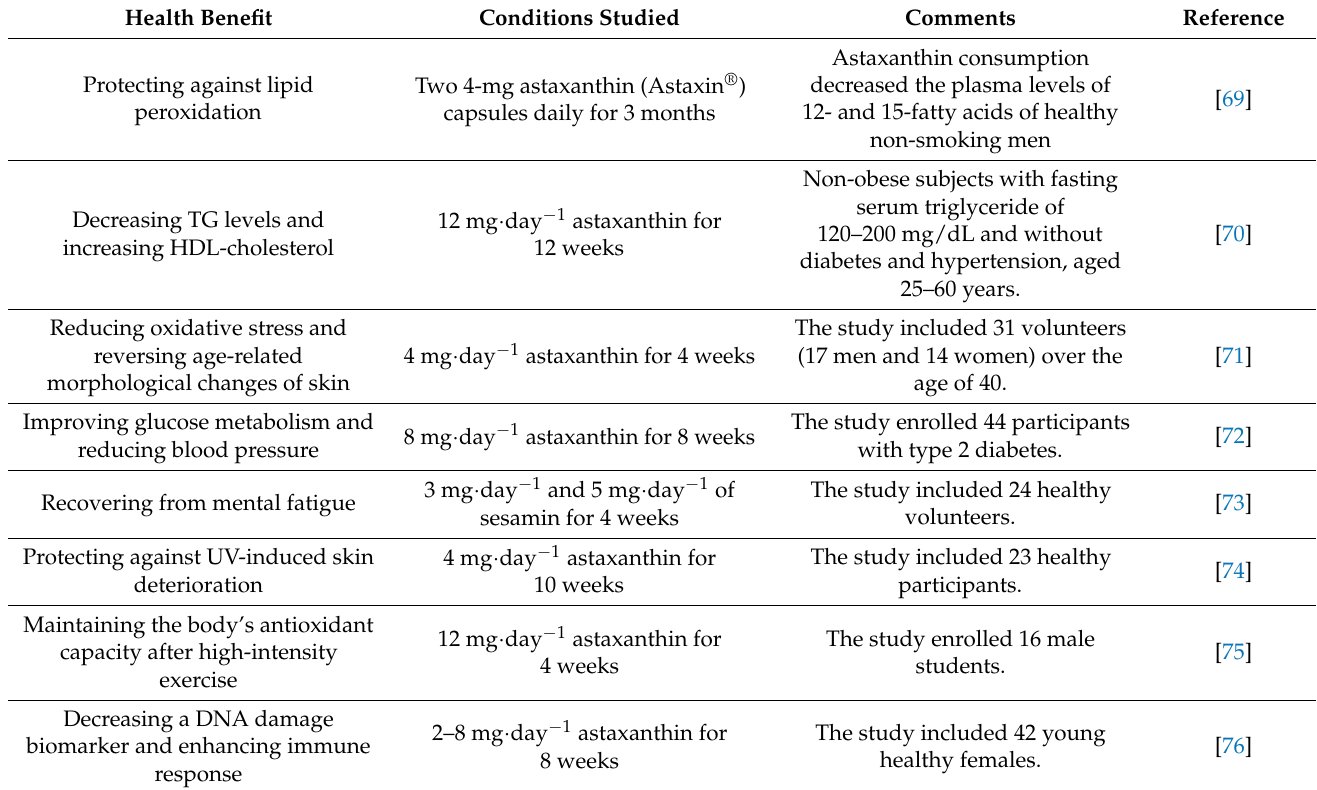
Table 3. Health benefits of natural astaxanthin when used as